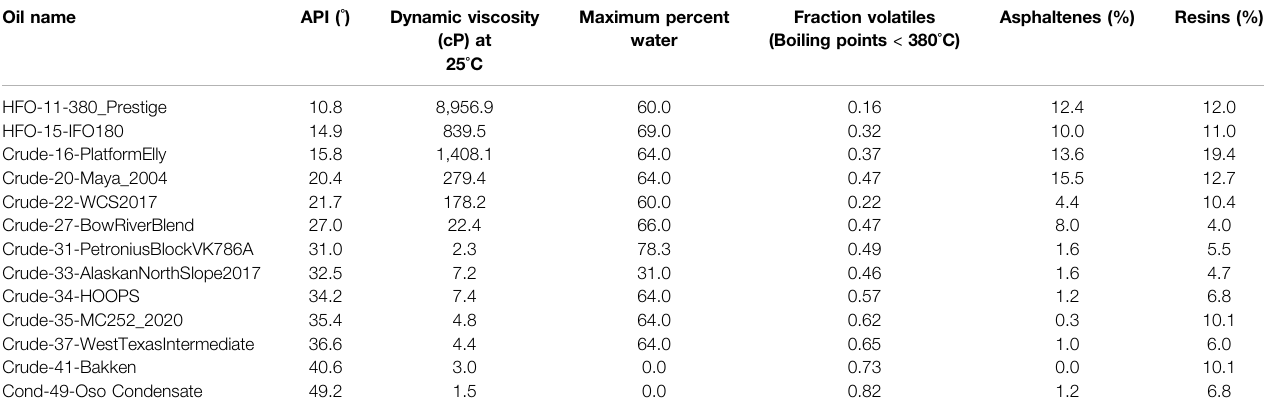
TABLE 1 | Initial properties of oils used for emulsi fi cation modeling. Oil